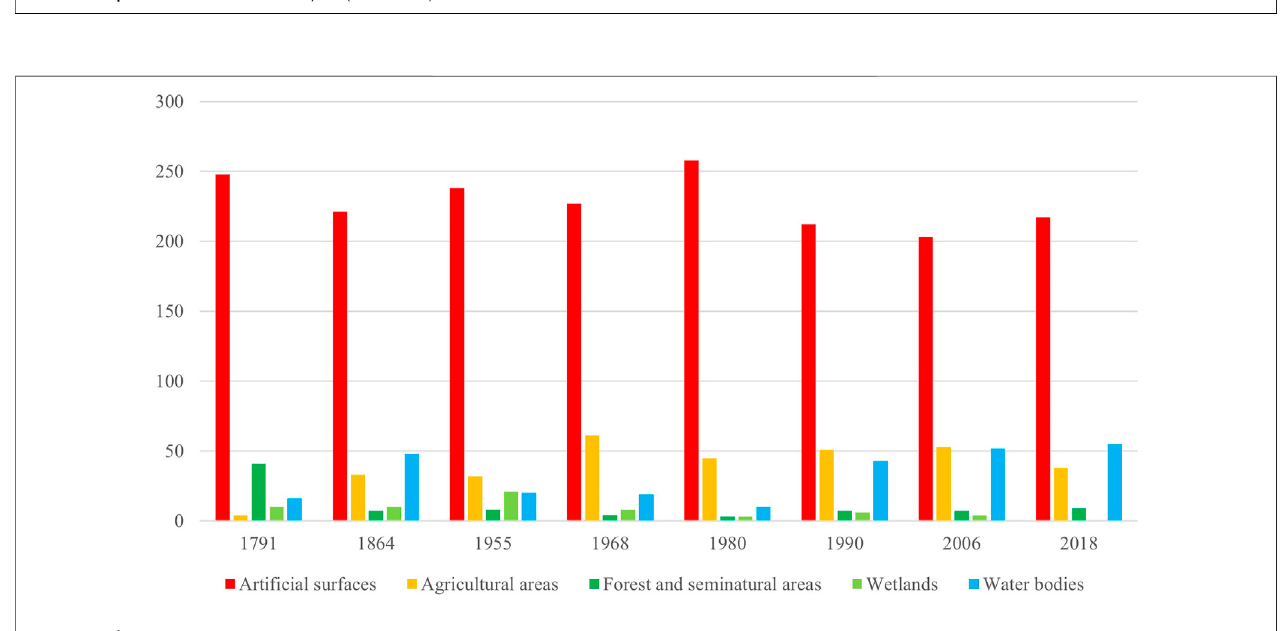
FIGURE 8 | Distribution of sites based on land use classi fi cation (1791 –